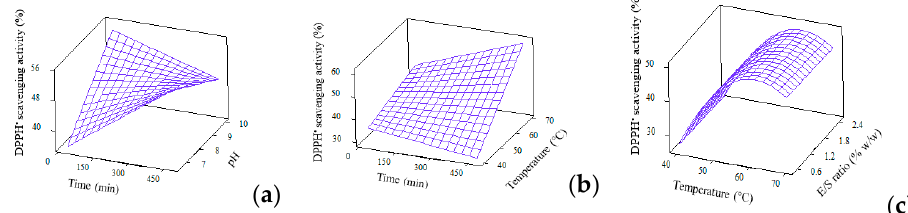
Figure 4. 3D surface plots for DPPH• radical scavenging (%) as affected by ( a ) Time and pH; ( b ) Time